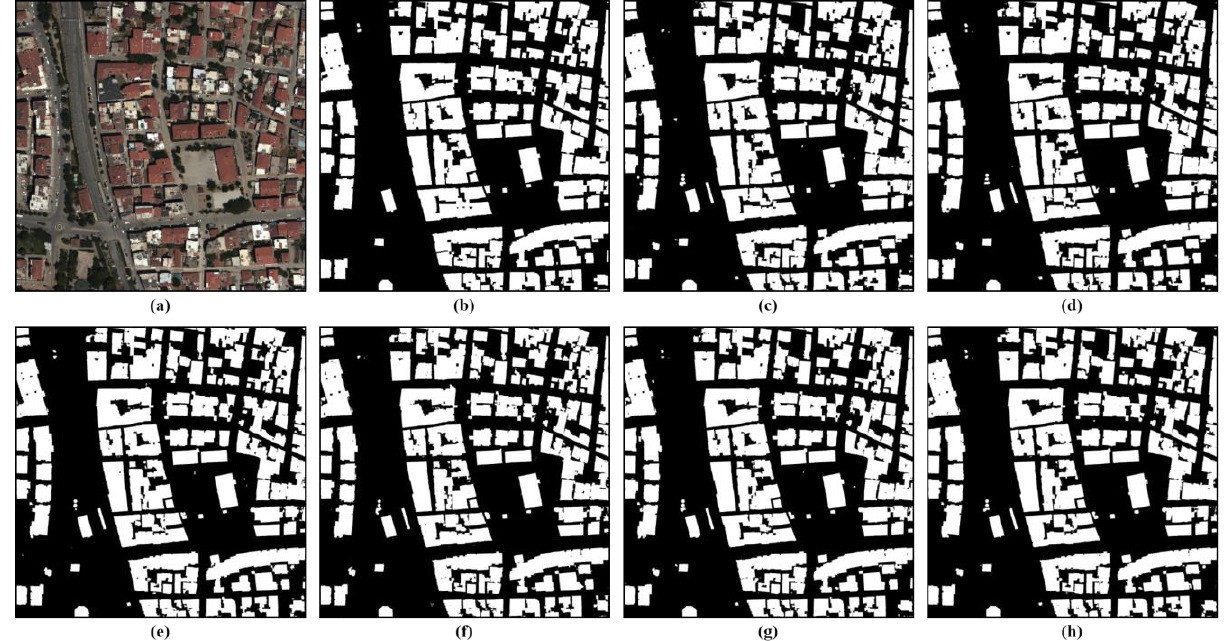
Figure 5. An overview of the RGB + nDSM predictions for the test area: (a) True orthophoto, (b) Ground truth, (c) U-Net+ResNet- 18, (d) U-Net+ResNet-50, (e) U-Net+SeResNet-18, (f) LinkNet+ResNet-18, (g) LinkNet+ResNet-50 and (h)